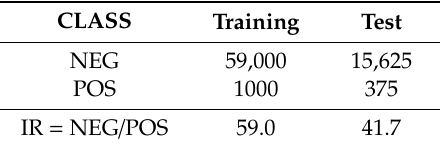
Table 2. Number of instances of each class in the training and test